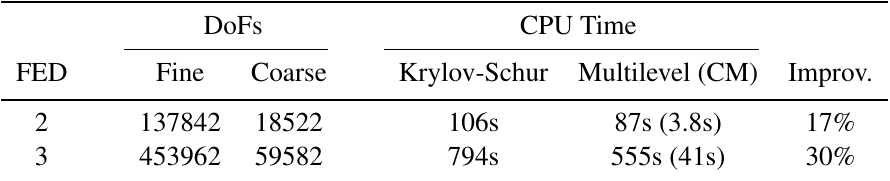
Table 1 Computational times of cuboid reactor